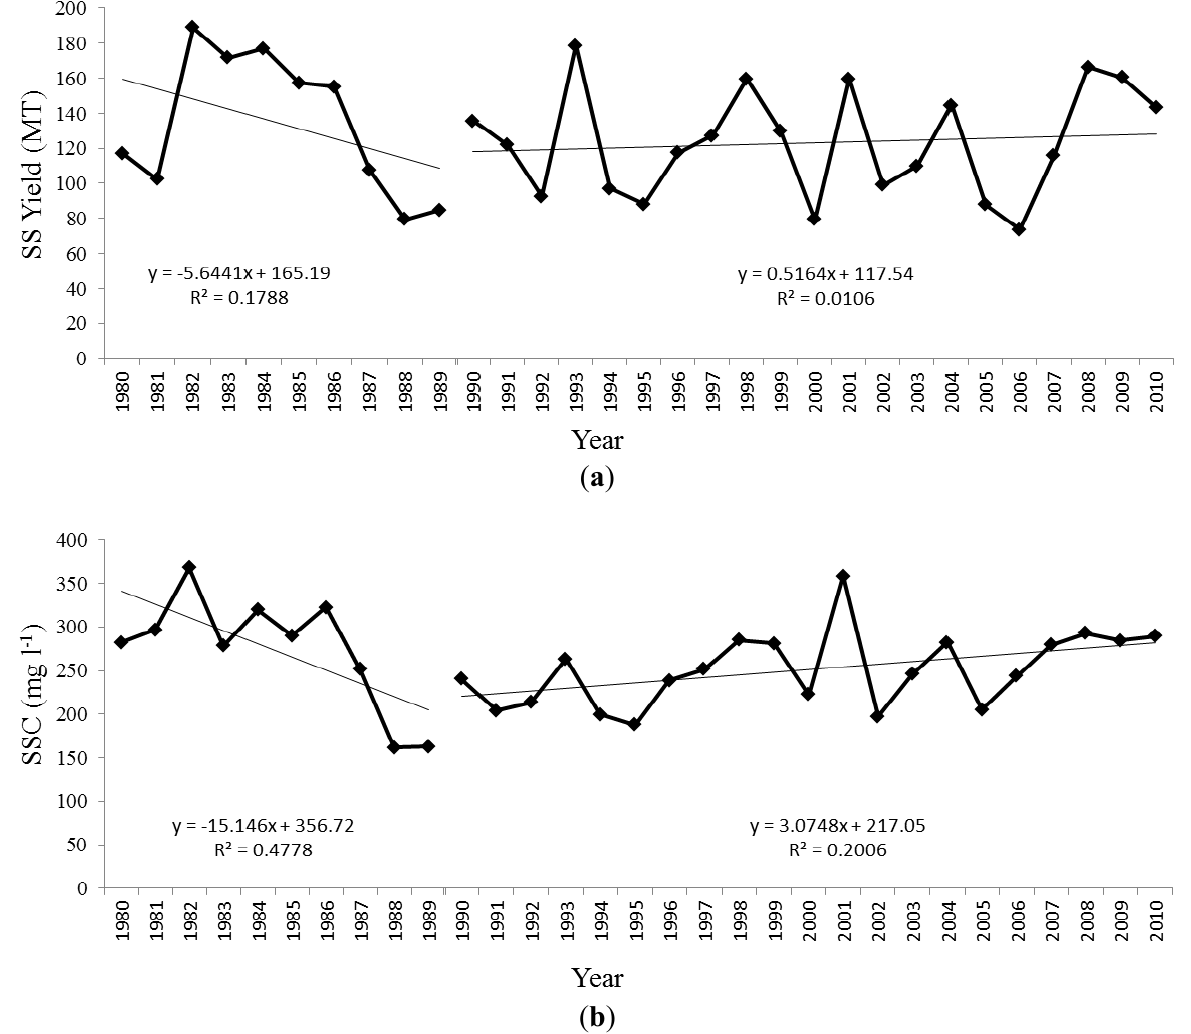
Figure 2. ( a ) Annual total suspended sediment yield in megatonnes and ( b ) mean suspended sediment concentration in milligrams per liter (SSC) for the Mississippi at Tarbert Landing, MS from 1980 to